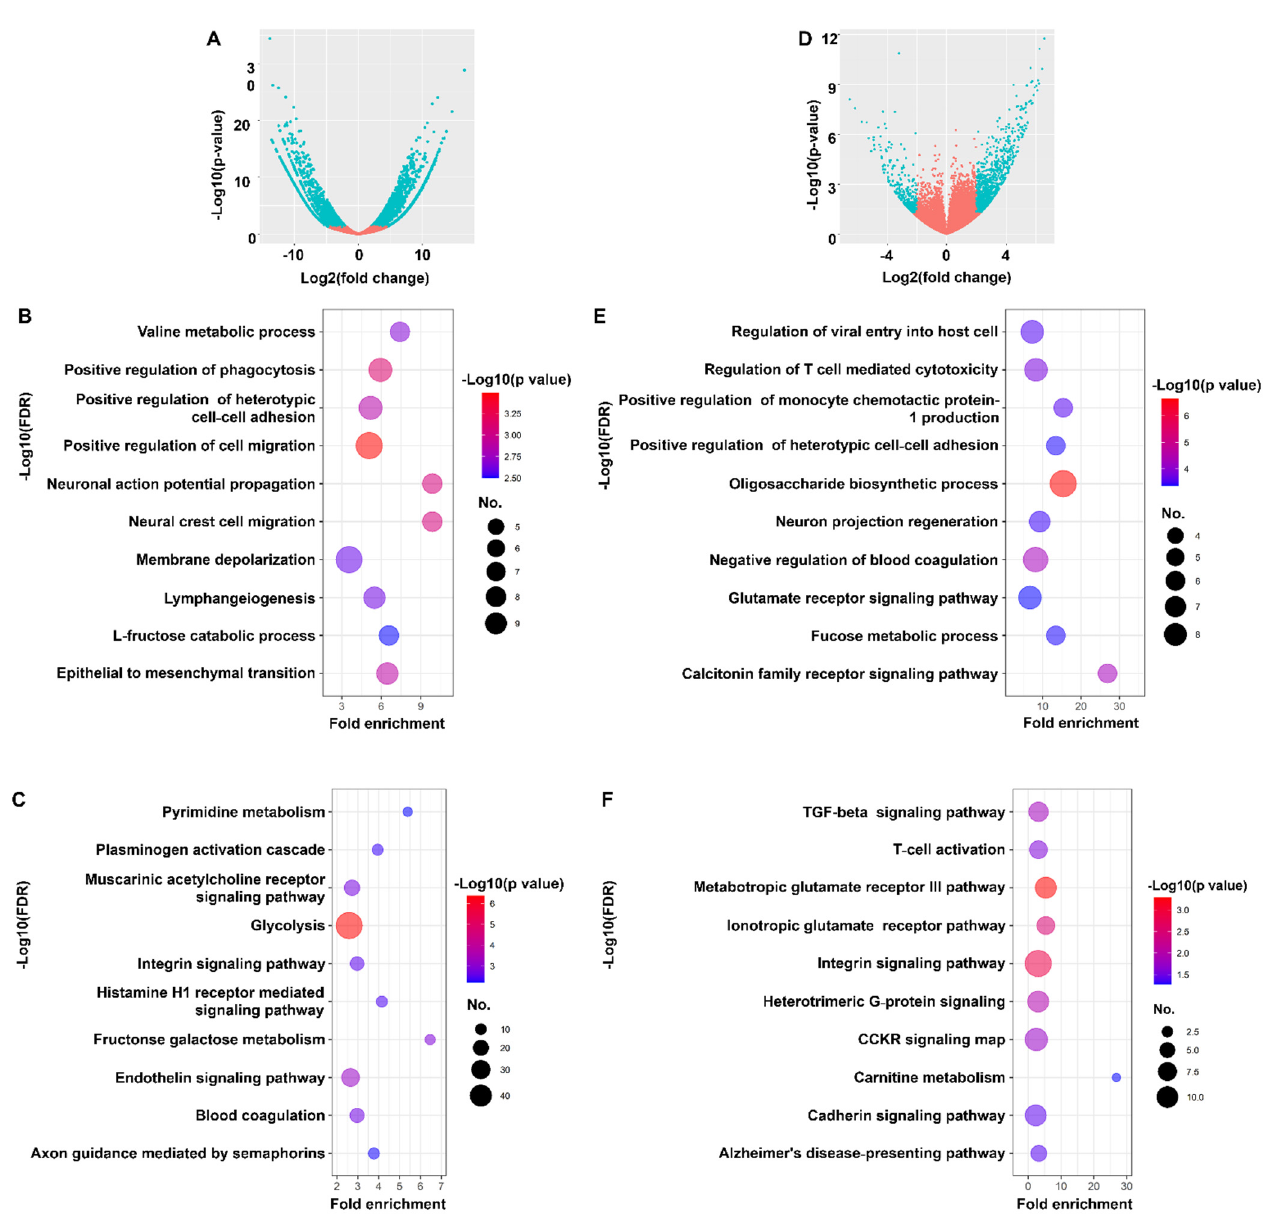
Figure 2. The characteristics and functional annotation of the DEGs in NPC and EBVaGC. The volcano plots illustrate the DEGs in NPC ( A ) and EBVaGC ( D ). The bubble diagram represents the result of functional enrichment analyses of DEGs of NPC and EB ‐ VaGC. ( B , C ) The top 10 enrichment results of the biological process and KEGG pathway in NPC and EBVaGC ( E , F ). The Y ‐ axis on the left indicates the top 10 functional enrichment results. The X ‐ axis indicates the percentage of genes involved in the biological processes and the KEGG pathway. The color represents the p ‐ value, and a range from red to blue indicates a low to high p ‐ value, respectively. The size of the bubble indicates the gene numbers involved in the biological process and KEGG